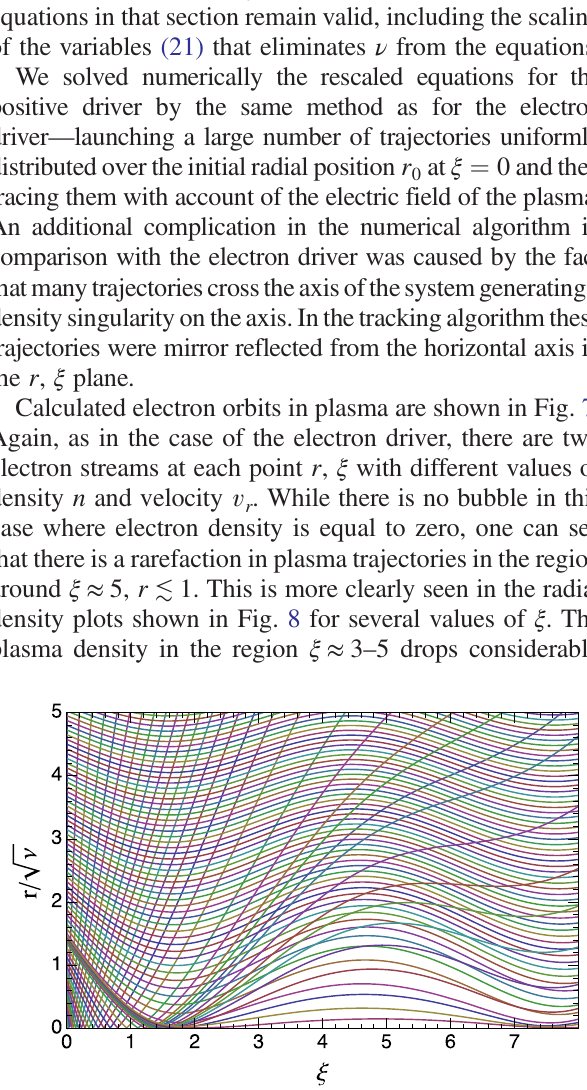
FIG. 8. Electron density distributions in radial directions for various values of ξ : (1) ξ ¼ 1 , (2) ξ ¼ 2 . 5 , (3) ξ ¼ 3 , (4) ξ ¼ 4 , (5) ξ ¼ 8 . Note that curve 5 has a maximum outside of the plot area and is seen as two light blue lines (each one indicated by number